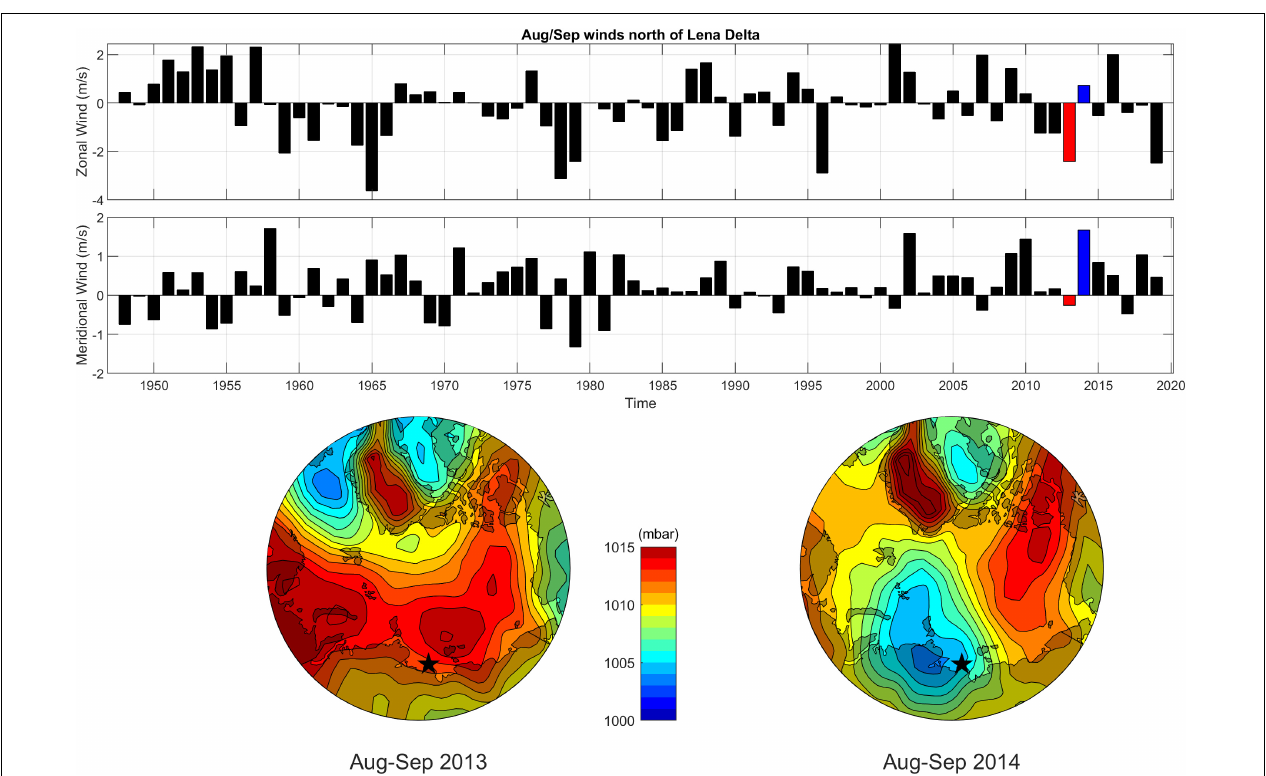
FIGURE 5 | Mean (1948–2019) zonal (top) and meridional (bottom) August and September winds (ms − 1 ) from ERA-I. Red and blue bars highlight 2013 and 2014, respectively. The corresponding sea level pressure (mbar) patterns for 2013 and 2014 are shown in the lower panels.